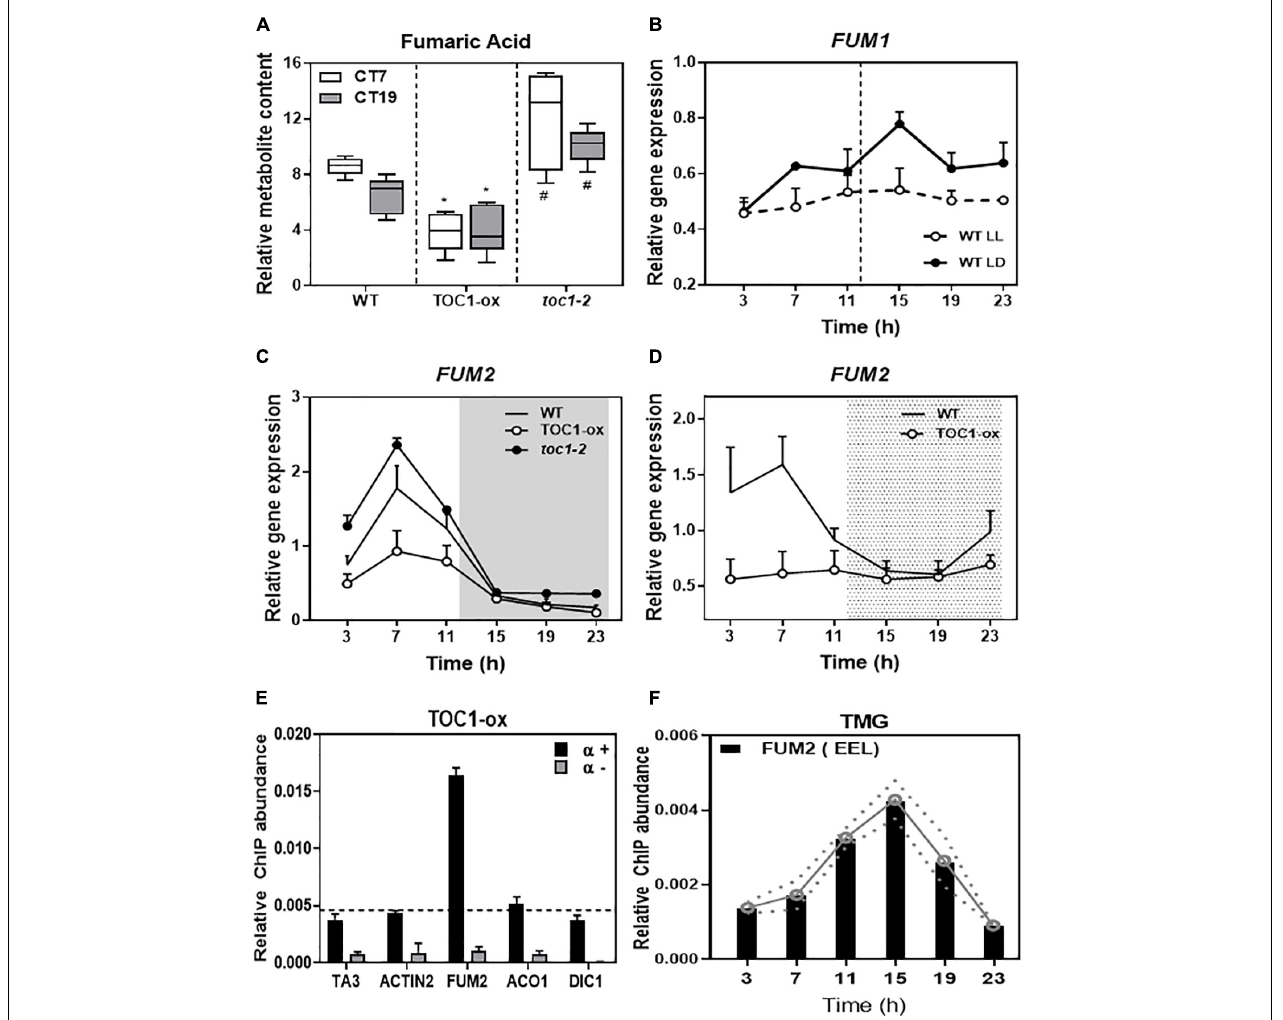
FIGURE 5 | TIMING OF CAB EXPRESSION1 controls the diurnal and circadian expression of FUM2 by direct binding to its promoter. (A) Relative fumaric acid content in WT, TOC1-ox and toc1-2 plants entrained under LD cycles and then transferred for 2 days to LL before sampling at Circadian Time 7 (7 h after subjective dawn) CT7 and CT19. (B) Time course analyses of FUM1 expression in WT plants grown under LD or transferred for 2 days to LL before sampling. (C) Time course analyses of FUM2 expression in WT, TOC1-ox and toc1-2 plants grown under LD. (D) Time course analyses of FUM2 expression in WT and TOC1-ox plants grown under LD transferred for 2 days to LL before sampling. (E) Chromatin immunoprecipitation (ChIP) assays with TOC1-ox plants grown under LD and sampled at ZT7. ChIP enrichment was calculated relative to the input. Samples were incubated with an anti-MYC antibody (+ α ) or without antibody (- α ). (F) ChIP assays with TMG plants grown under LD and sampled every 4 h over the diurnal cycle. ChIPs were performed with an anti-GFP antibody to immunoprecipitate the GFP-tagged TOC1 protein. ChIP enrichment was calculated relative to the input. The white and gray areas in panel (C) represent day and night, respectively. The white and dotted areas in panel (D) represent subjective day and subjective night, respectively. Three biological replicates were performed for all experiments, with plants grown independently, and with samples collected, processed and analyzed at different times. Two-tailed, t -test of WT Vs. TOX1ox p -values: * p < 0.05 and WT Vs. toc1-2 p -values: # <